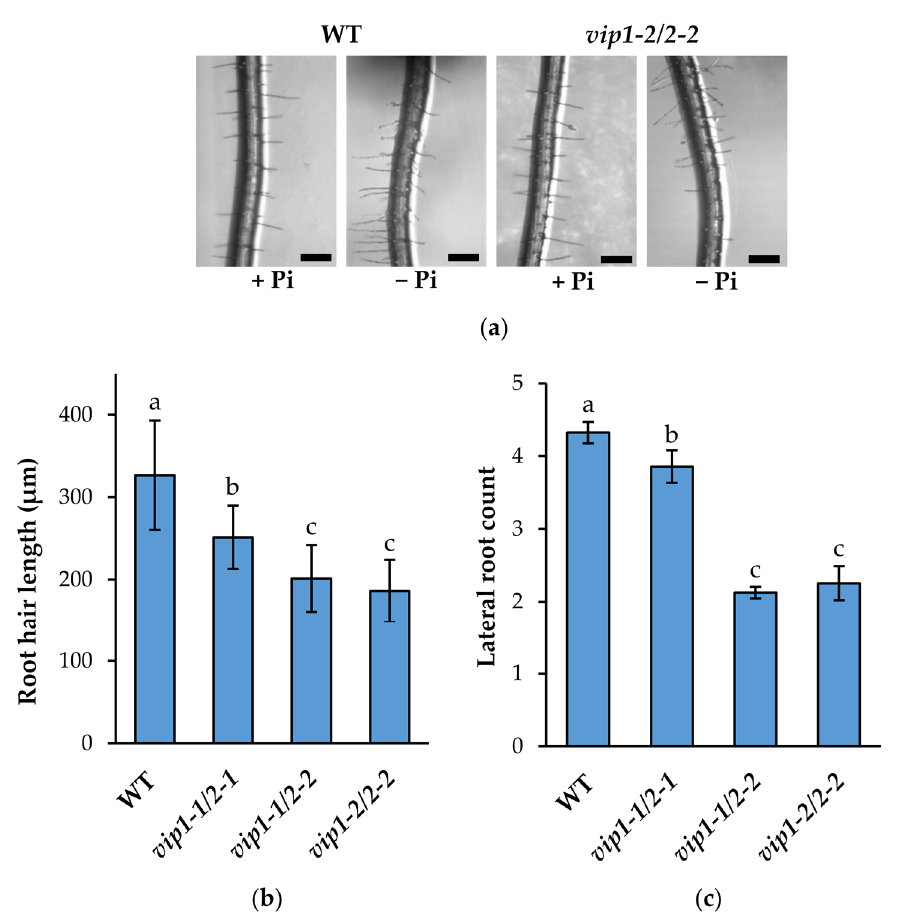
Figure 4. Root system architecture (RSA) responses in vip mutants. ( a ) Close-up images of 14-day-old WT and vip1-2 / vip2-2 primary roots from seedlings grown on phosphate-replete (+Pi) and phosphate-limiting ( − Pi) MS media (scale bars indicate 250 µ m). ( b ) Root hair length of seedlings grown on phosphate-limiting media. Data presented are the average ± SD of two replicate experiments, ( n = 400–500 observations). ( c ) Lateral root count of seedlings grown on phosphate-limiting media. Data presented are the average ± SD of three bioreplicate experiments ( n = 30 observations/bioreplicate). Different letters indicate statistically significant means (Tukey HSD, α =